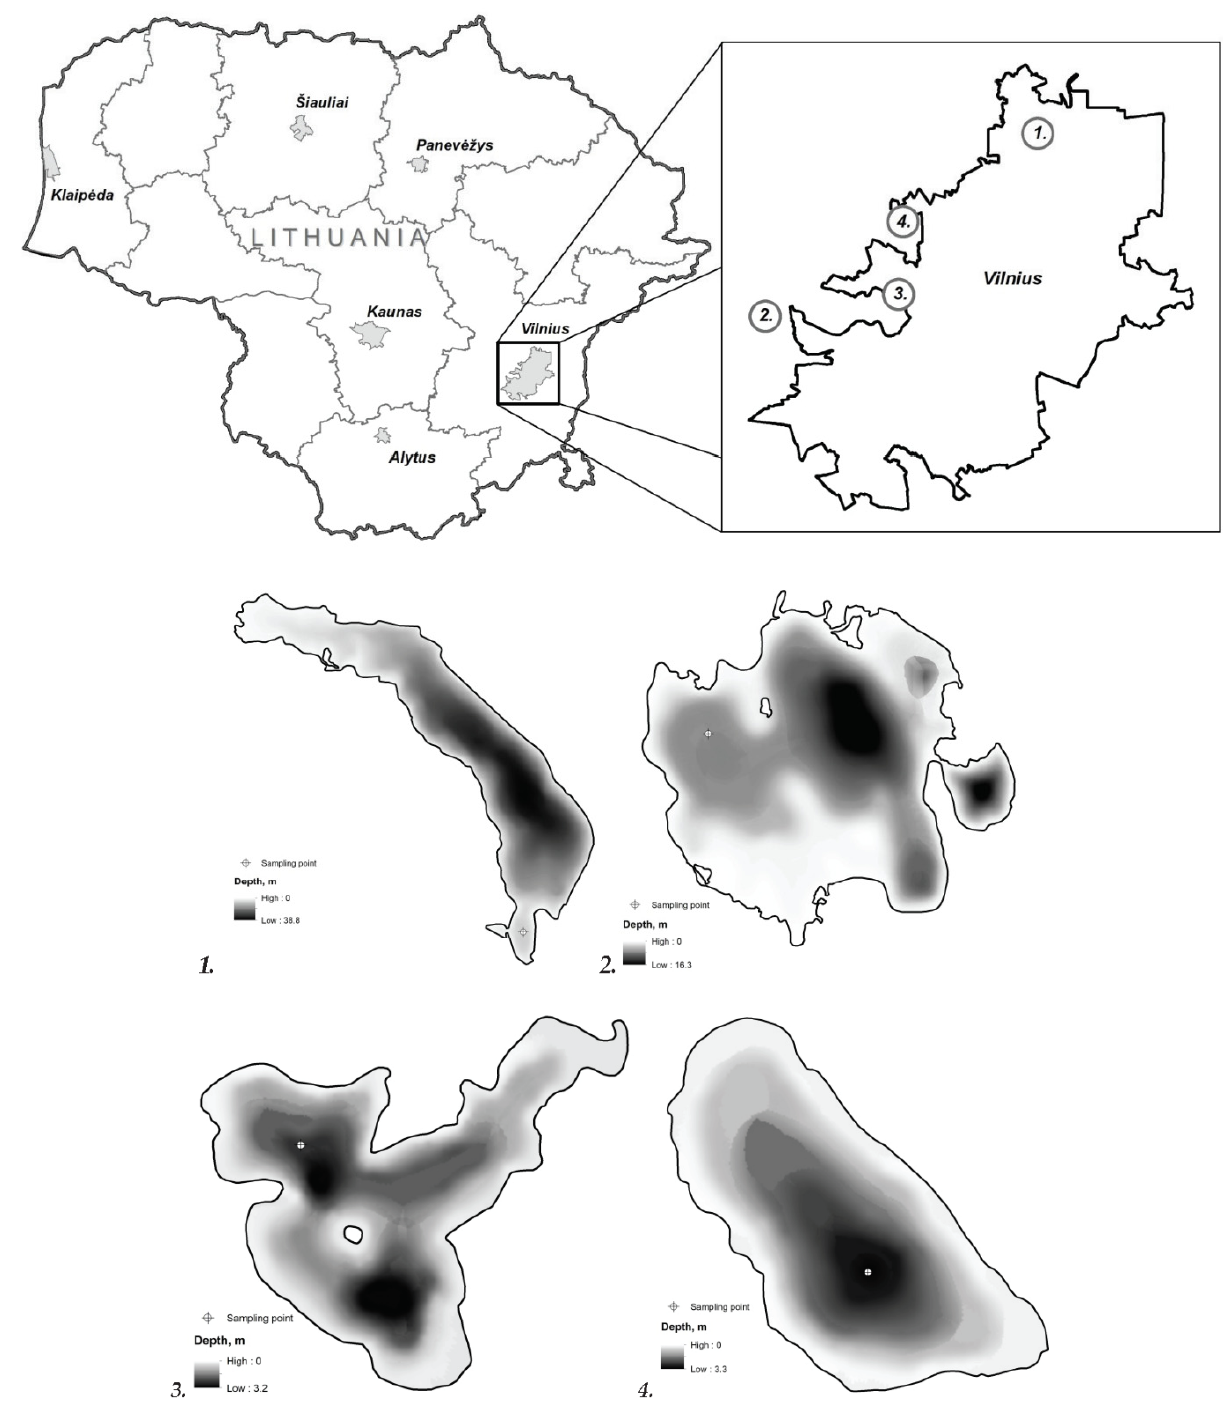
Figure 1. Location of investigated lakes: 1—Balsys, 2—Didžiulis, 3—Salot ė , 4—Gineitišk ė s. The depth of shallow (unconfined) groundwater in the vicinities of all of these lakes varies from 1 to 5 m and depends on morphology of the kettle hole [26] thus stable ali- mentation by groundwater is a part of the hydrological regime of the lakes. The average annual pH values of lakes that are shallower than 4 m in depth are 8.07, maximum—9.5